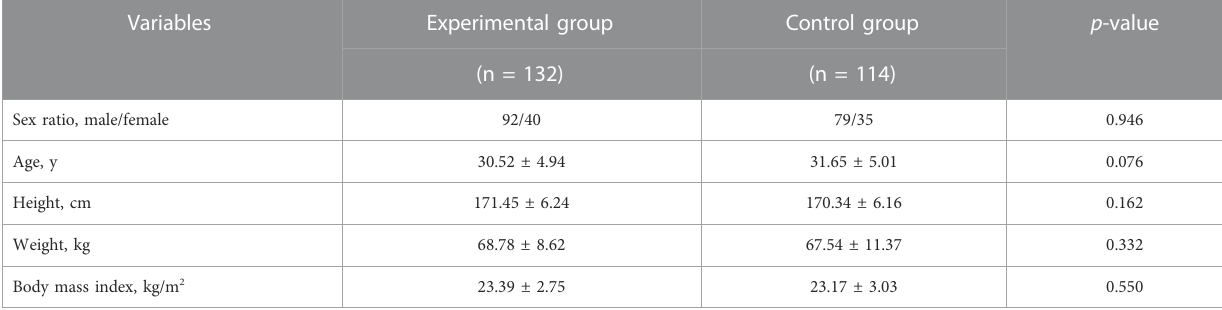
TABLE 1 Demographic data of the subjects in two